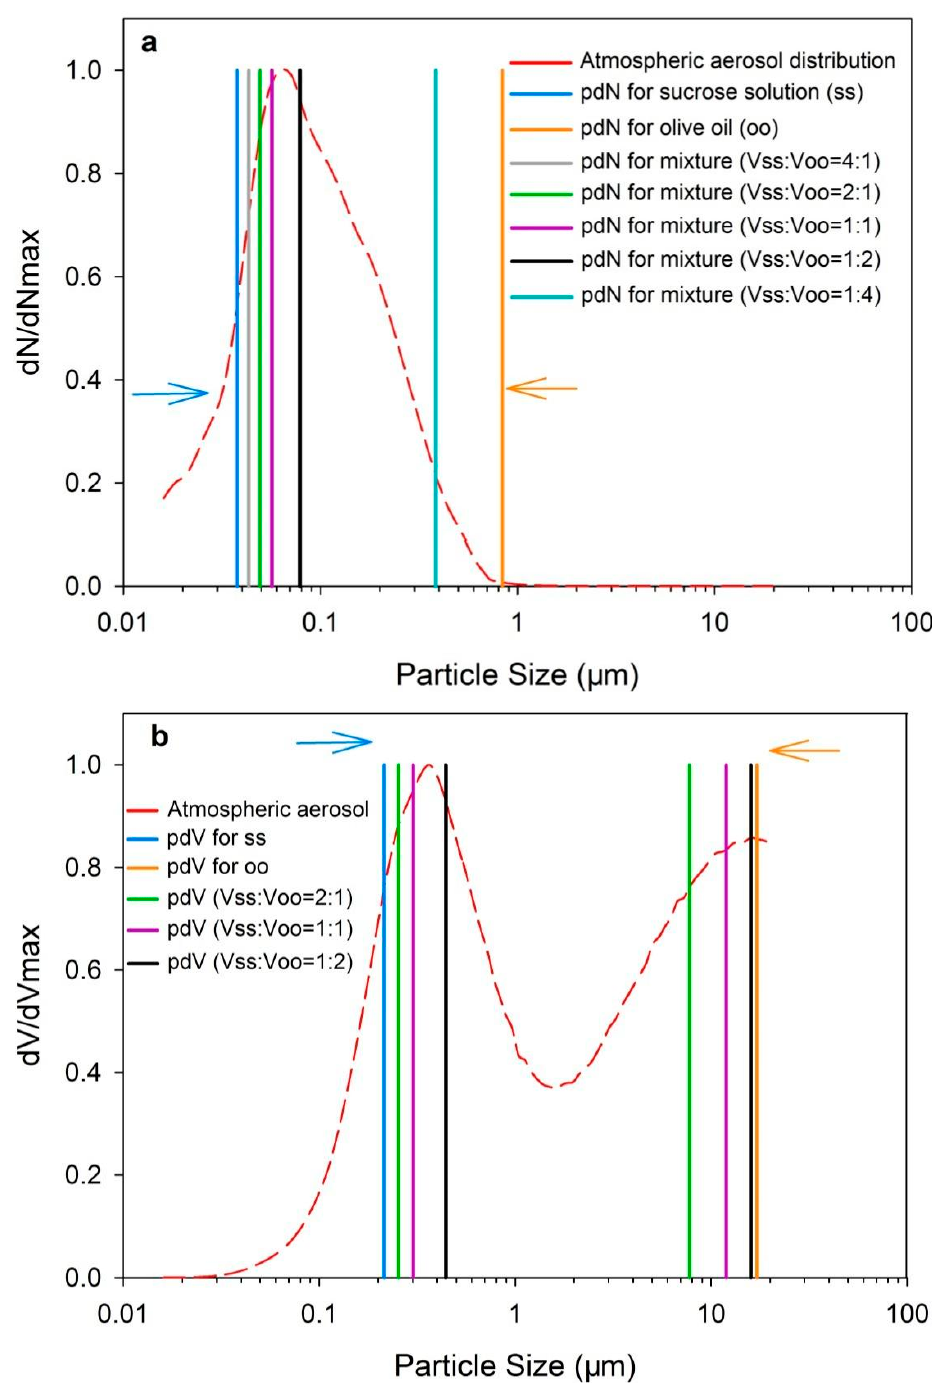
Figure 5. The influence of different percentages on the normalized particle number ( a ) and volume ( b ) size distribution generated by olive and sugar mixture solution. pdN means the peak diameter of particle number distribution; pdV means the peak diameter of particle volume distribution.